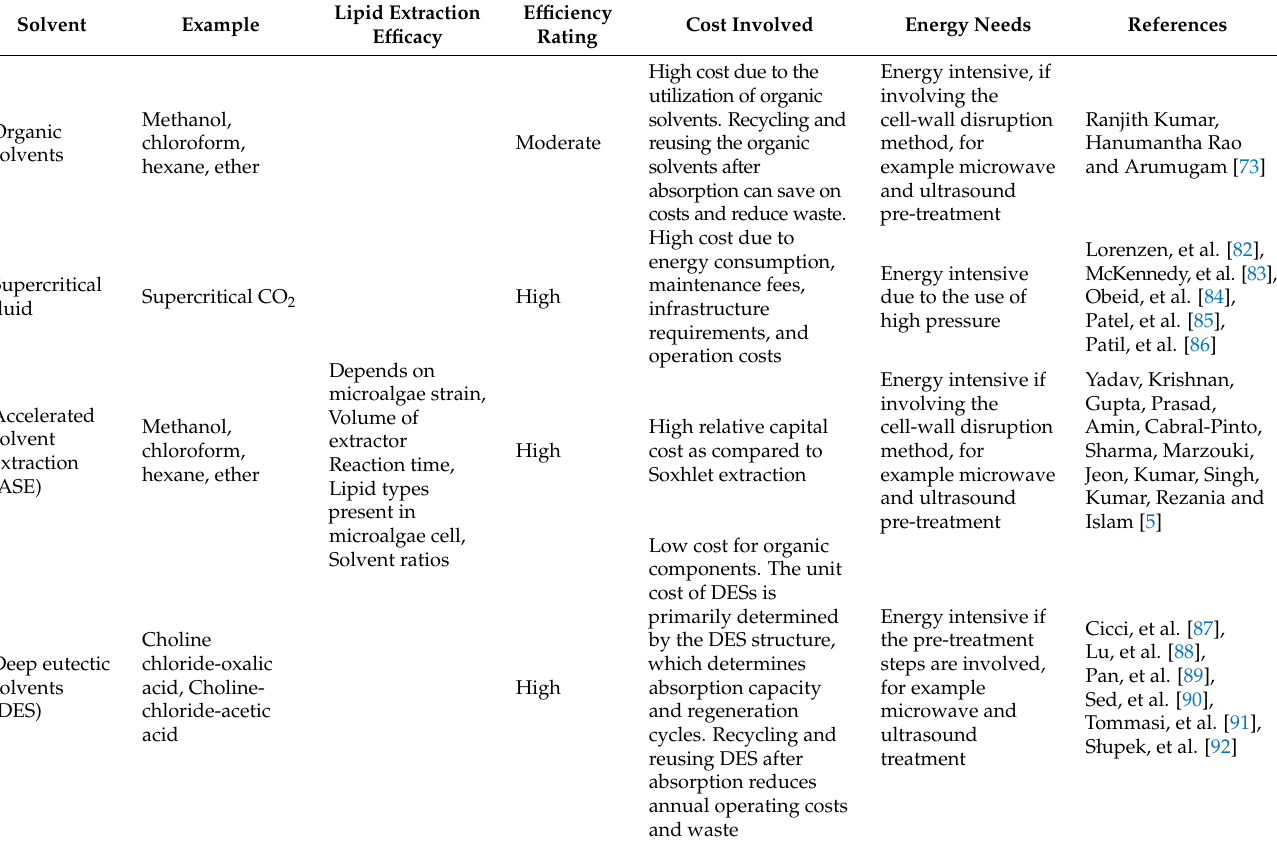
Table 1. Comparison of solvent-mediated lipid-extraction technologies, costs, and energy